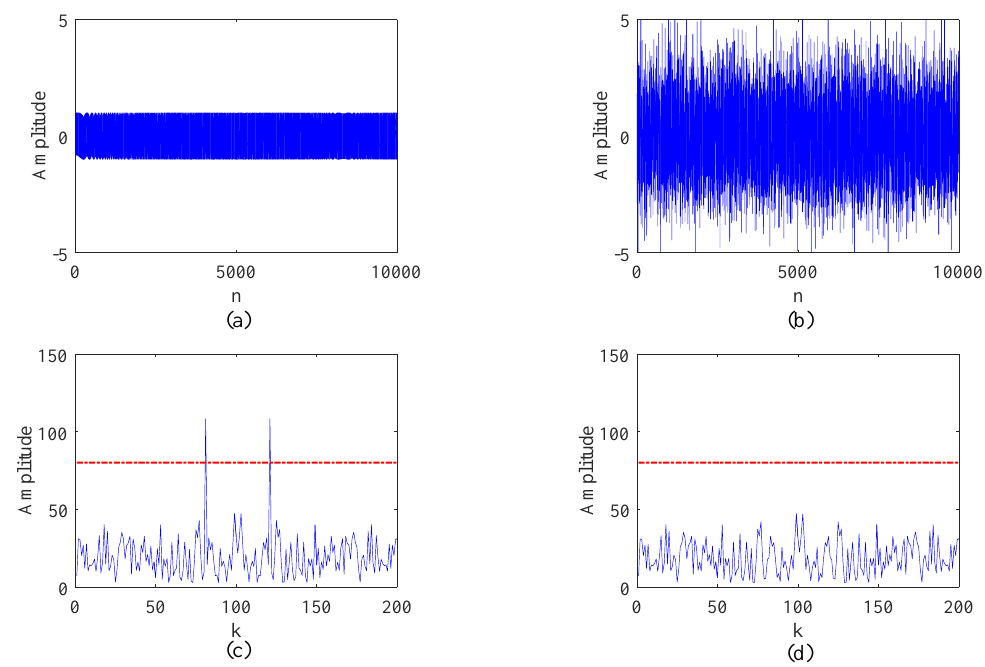
Figure 4. Signal detection simulation results. ( a ) Chirp signal in the time domain; ( b ) noise in the time domain; ( c ) maximum S ( k ) of the noisy chirp signal in the frequency domain; ( d ) maximum amplitude of the noise in the frequency domain. The red line is the preset threshold for